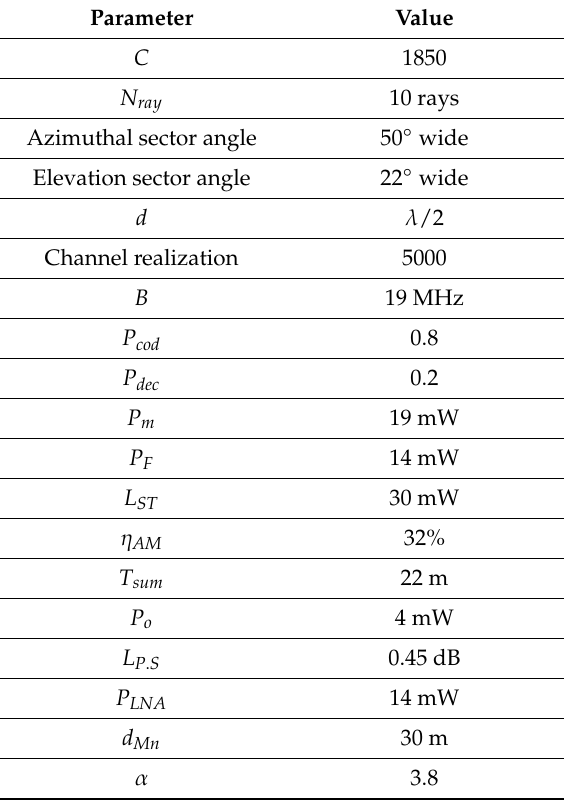
Table 2. Simulation